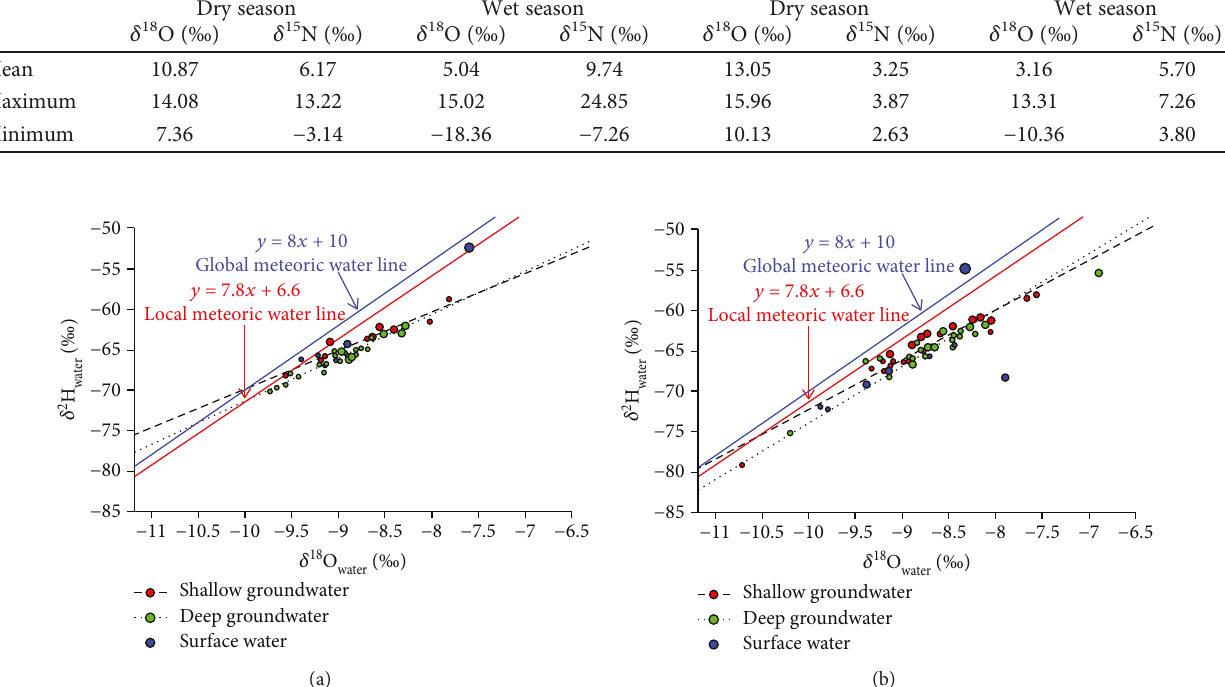
Figure 3: Plot of δ 2 H and δ 18 O for shallow groundwater, deep groundwater, and surface water samples collected in the study region: water water (a) dry season; (b) wet